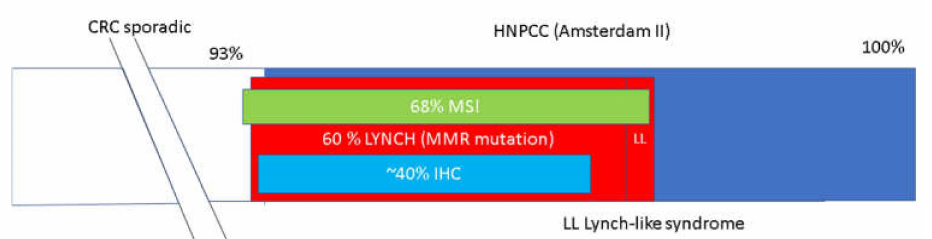
Figure 2. Nonpolyposis colorectal cancer (CRC) [25–27]. Abbreviations are as follows: HNPCC— hereditary nonpolyposis colorectal cancer; IHC—immunohistochemistry; LLS—Lynch‑like syn‑ drome; LS—Lynch syndrome; MMR—mismatch repair; MSI—microsatellite